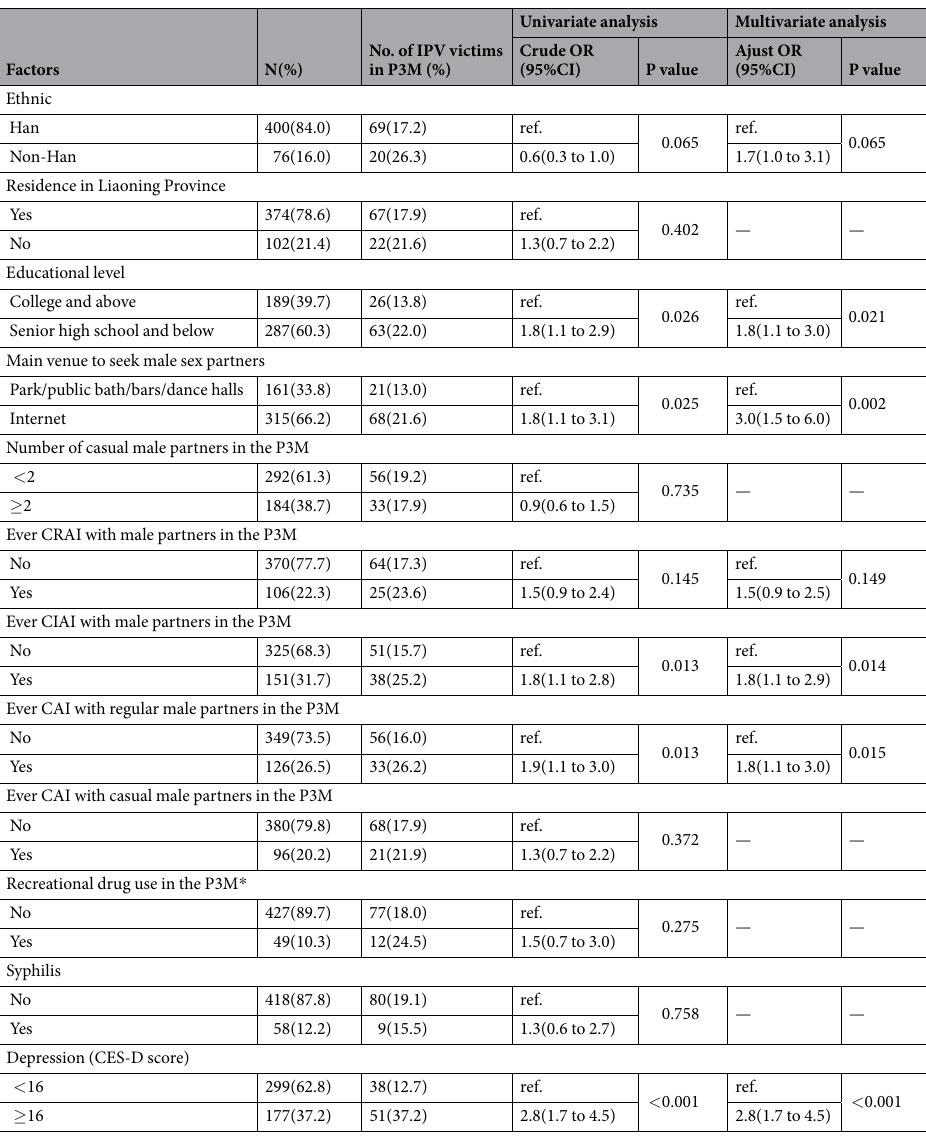
Table 2. Baseline characteristics of MSM who were victims of IPV in the past 3 months (N = 476). Abbreviations: PY = person-years, CI = confidence interval, OR = odds ratio, P3M = past 3